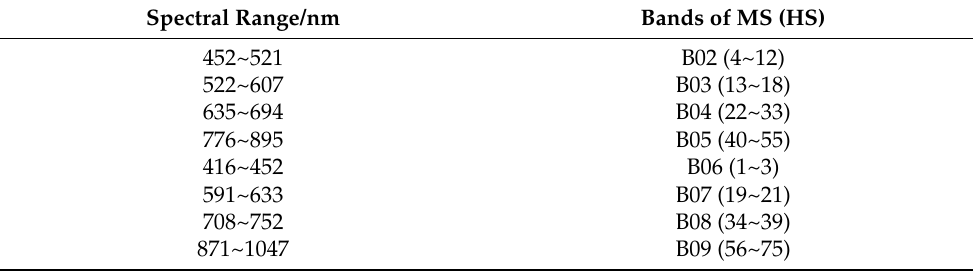
Table 2. Correspondence between the eight MS bands and seventy-five HS bands.